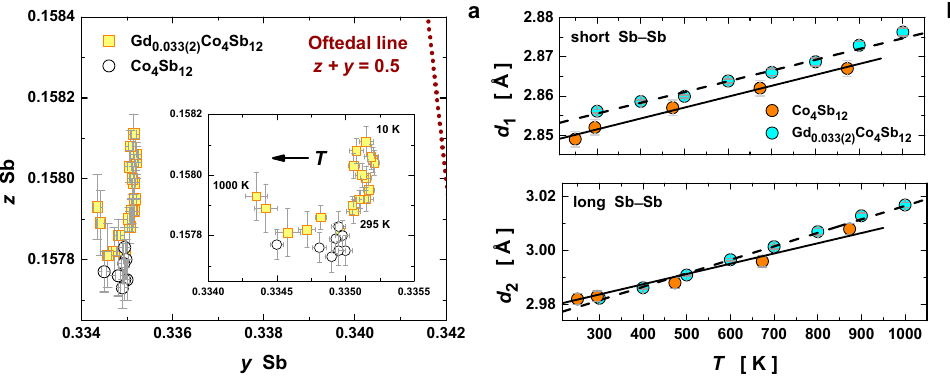
Figure 4. ( a ) Oftedal plot with the Oftedal line (red dotted line, such that 𝑧 + 𝑦 = 0.5) comparing Gd-filled and unfilled Co 4 Sb 12 . ( b ) Temperature dependence of the short and long Sb–Sb distances in the (Sb 4 ) ring for both Gd-filled and unfilled Co 4 Sb 12 .